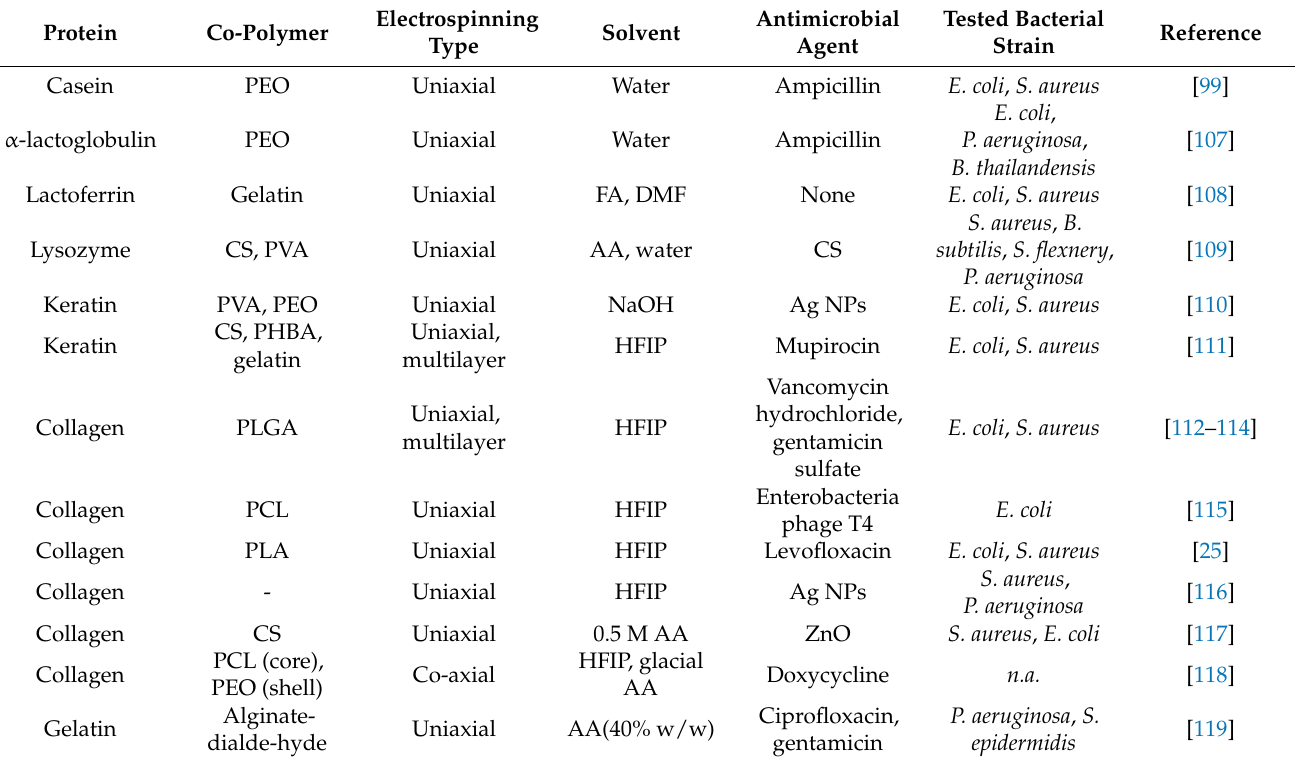
Table 2. Electrospun animal-based proteins with antimicrobial activity.